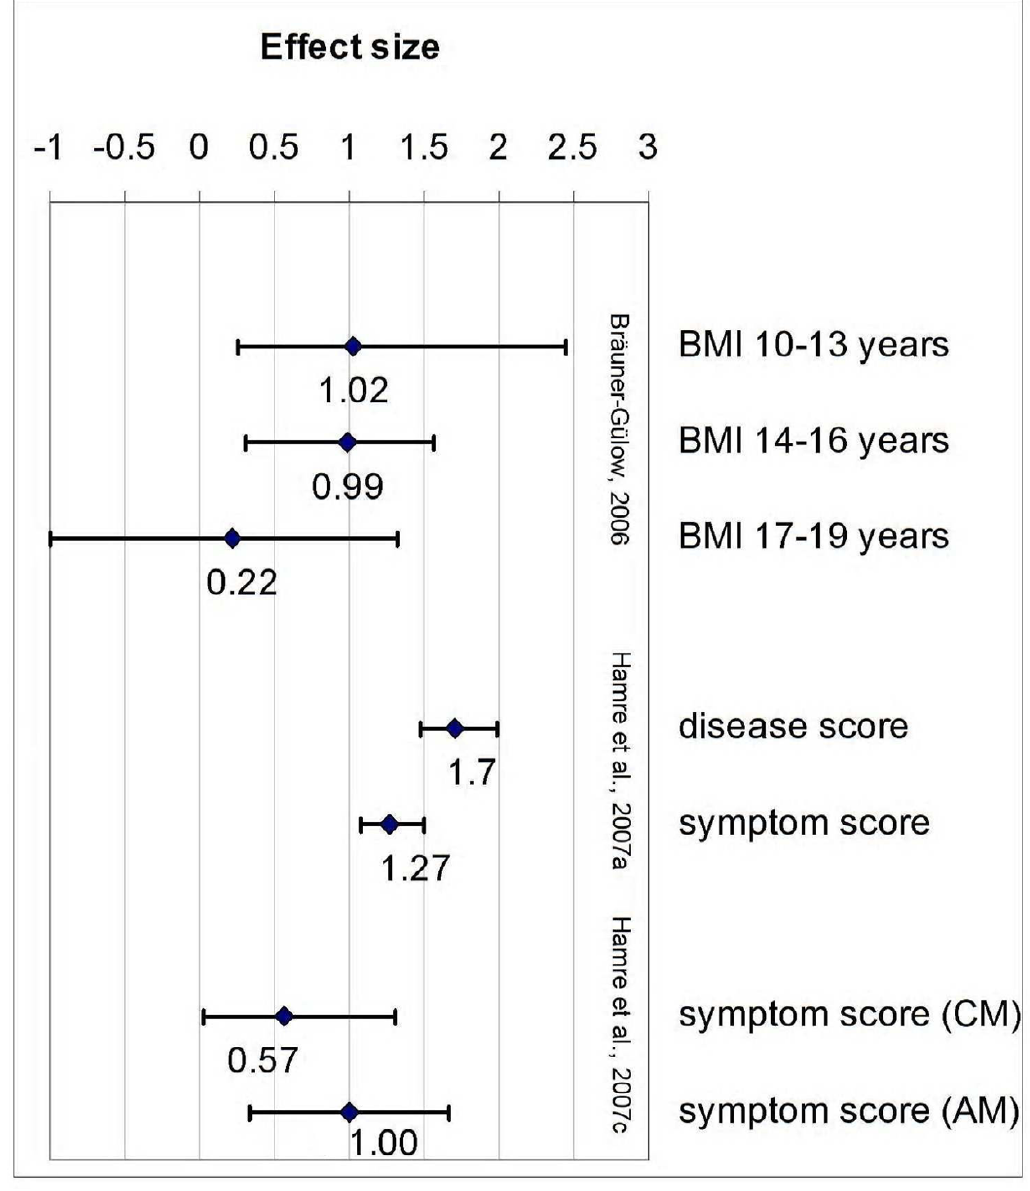
Figure 1 Effect sizes (Cohen's d) of studies on EYT . Analysed variables of the respective studies were indicated.